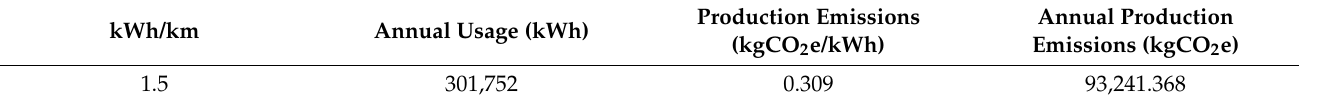
Table 8. Full Electric Powertrain Usage Calculations.